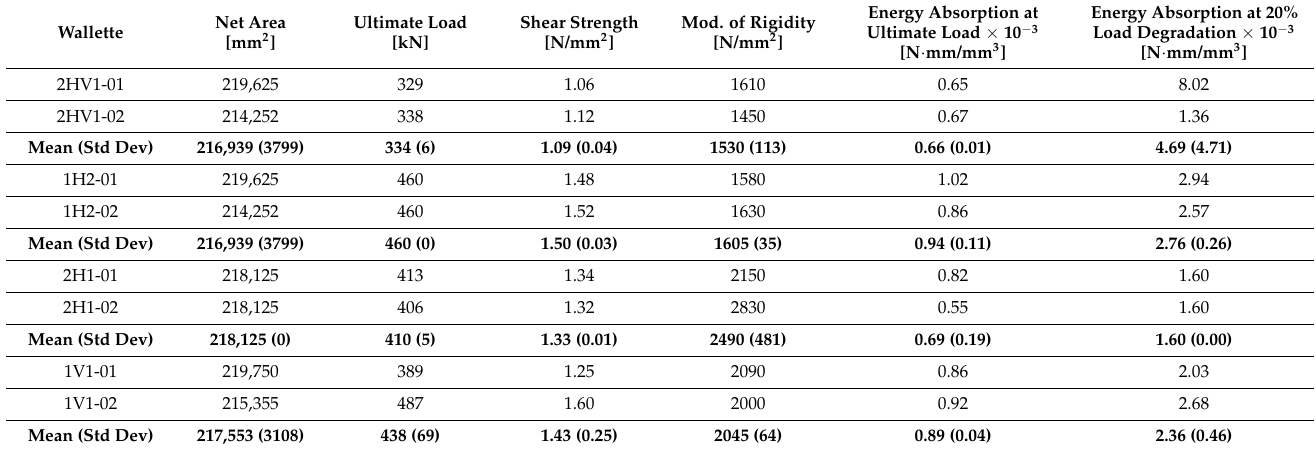
Figure 14. Wallettes reinforced with TSB vs. unreinforced ones in terms of ultimate load, shear strength, modulus of rigidity, and absorbed energy at 20% force degradation. ( a ) ultimate load; ( b ) shear strength; ( c ) modulus of rigidity; ( d ) absorbed energy at 20% force degradation. Table 10. Ultimate load, shear strength, modulus of rigidity, and energy absorption of Type 3